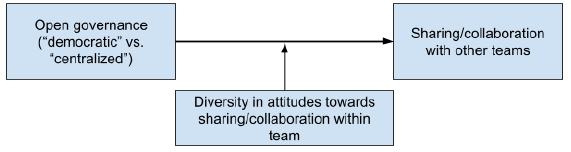
Fig. 1. Open governance, sharing/collaboration, and the moderating role of team diversity at the team level Some of our team members challenged the underlying